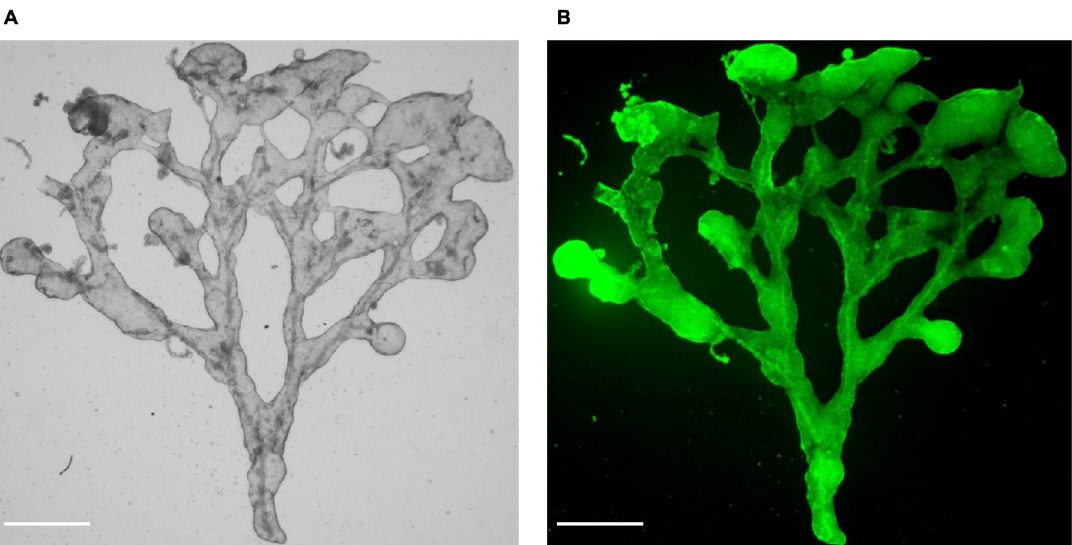
Figure 5. Biliary trees grown on micropatterns can be detached. Biliary tree from NRCs:HUVEC 10:1 co-culture detached from a 60° angle-micropattern, plated on Matrigel in the co-culture medium. ( A ) brightfield and ( B ) fluorescence stereomicroscopy images after a fluorescein secretion test showing the luminal tubular network, scale bar = 1 mm.